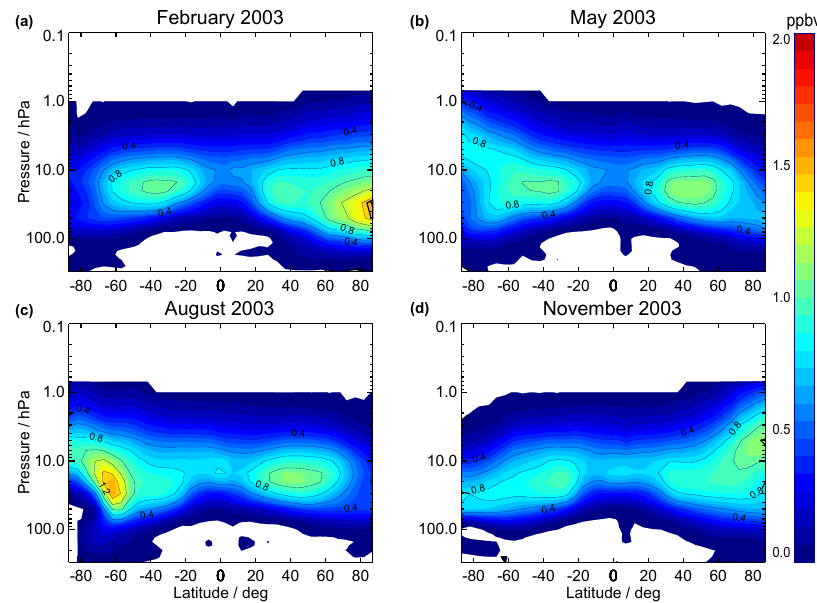
Figure 7. ClONO 2 latitude–pressure cross sections for February, May, August, and November 2003 as measured with MIPAS.